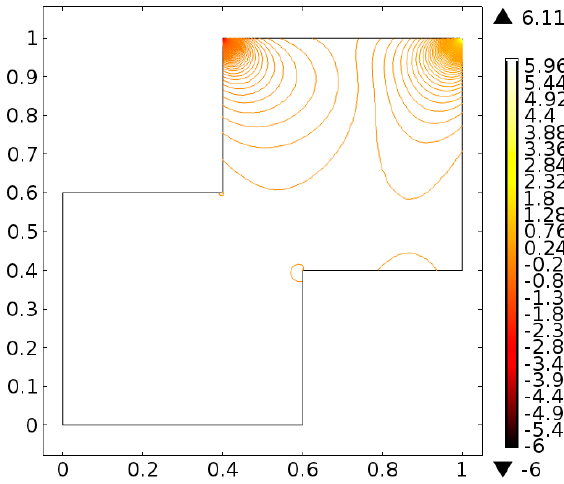
Figure 15. Pressure distribution at Re = 50 for case-I.